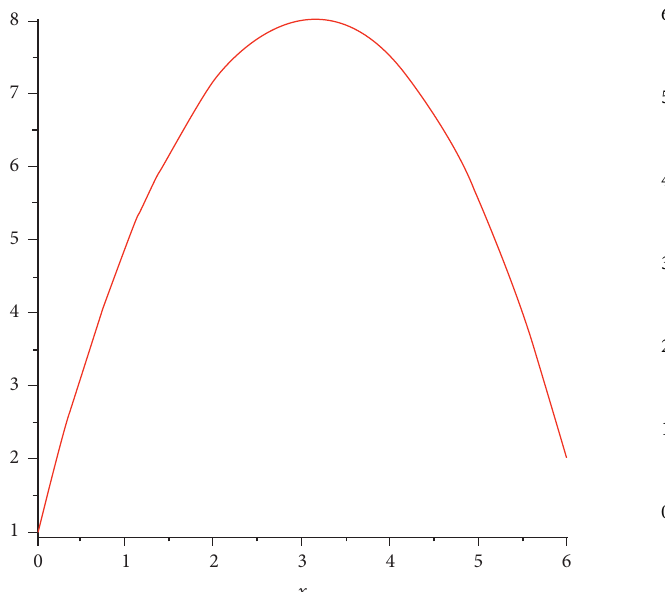
Figure 12: Monotone increasing data are preserved.